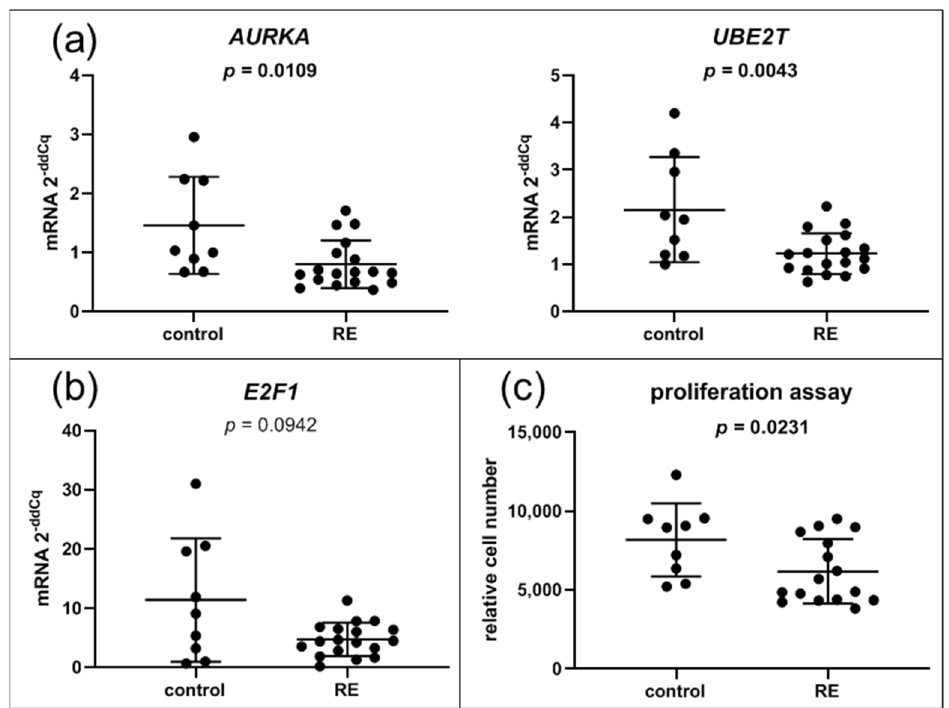
Figure 7. Cell cycle: VFF from RE patients have decreased expression levels of E2F target genes and decreased proliferation. ( a ) Gene expression of most altered single components of significantly regulated hallmark pathway E2F targets were evaluated by qPCR; ( b ) gene expression of the transcription factor E2F1 , ( c ) proliferation assay. Graphs show mean ± SD of 9 to 18 samples per group (control: n = 9, RE: n = 16–18); Groups were compared by Student‘s t -test, with Welch‘s correction if variances differed; in case of non-Gaussian distribution, Mann–Whitney rank test was conducted. p ≤ 0.05 was considered significant.